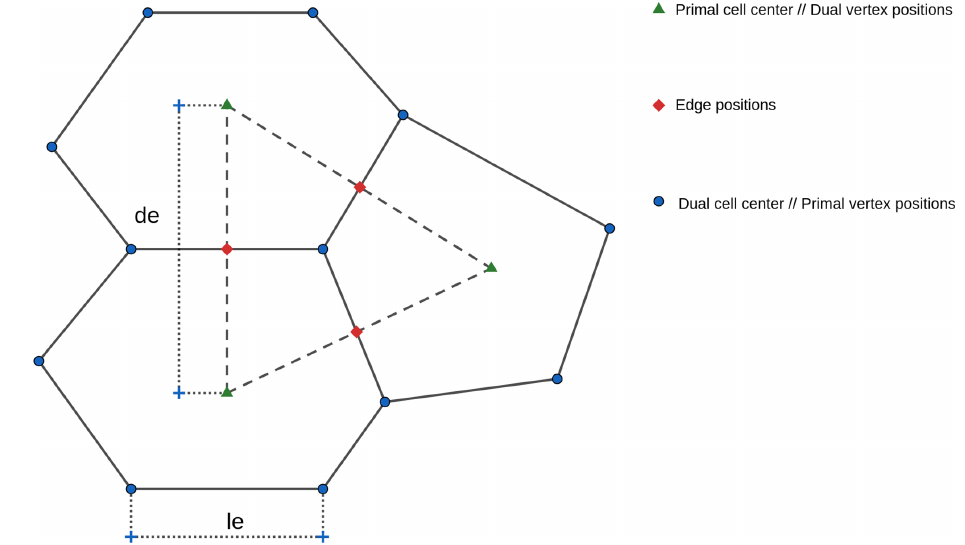
Figure 4. Variable positions for a C-grid